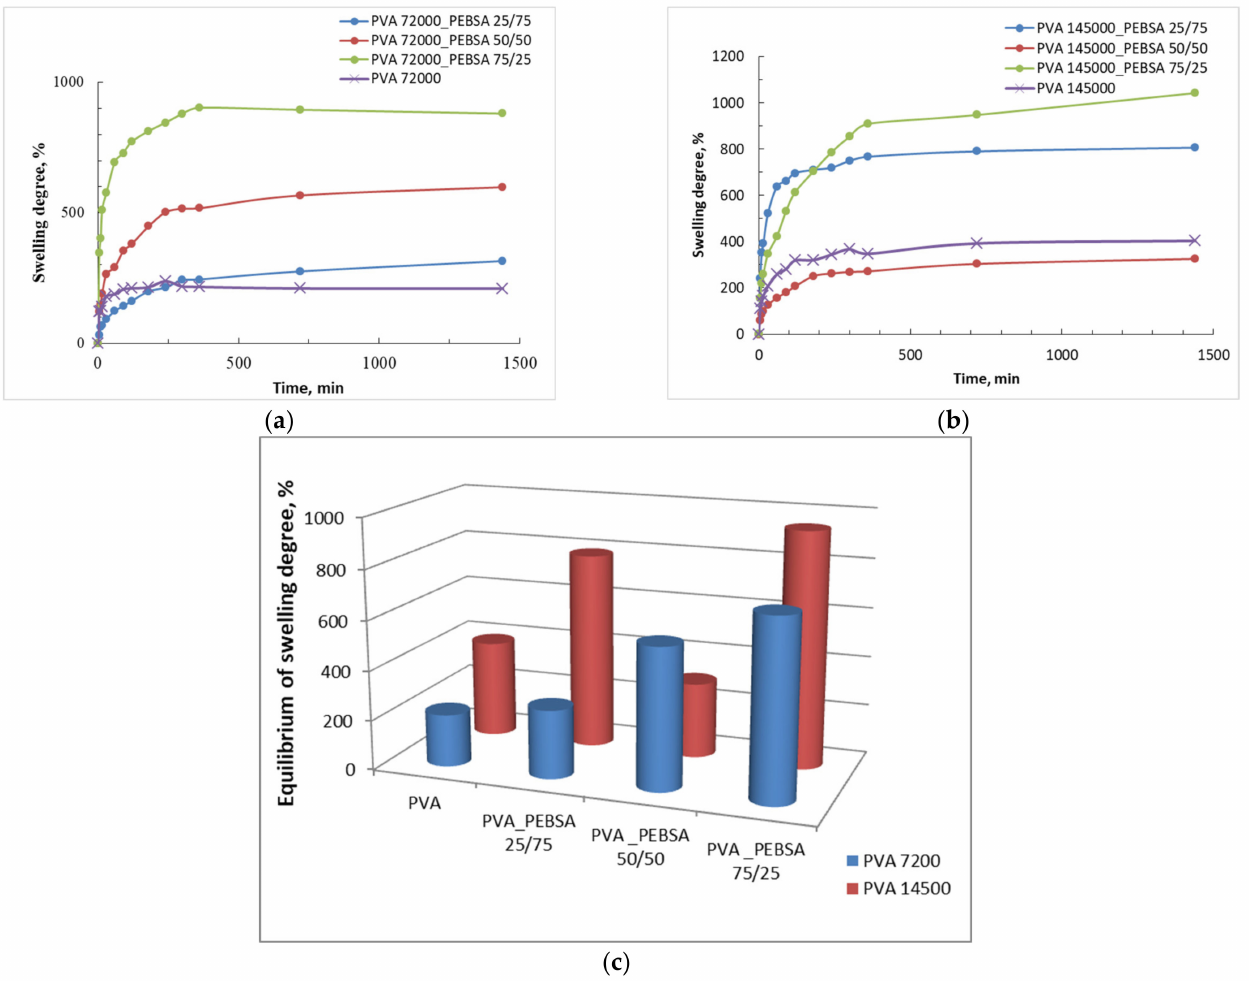
Figure 6. Degree of swelling vs. immersion time (min) for different composition PVA/PEBSA cryogels: ( a ) Mw PVA = 72,000 Da, ( b ) Mw PVA = 145,000 Da and ( c ) comparison between the samples regarding the maximum swelling